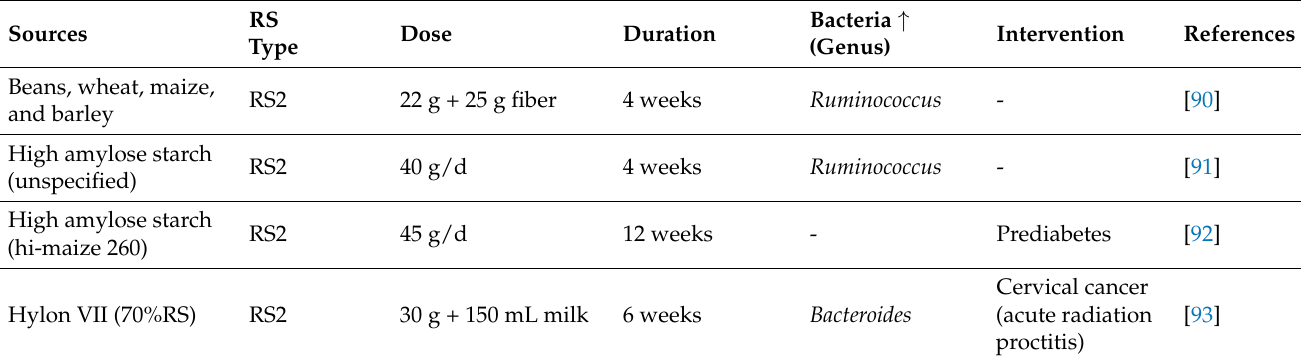
Table 3. Effect of dietary cereals- and tubers-derived resistant starches on human gut